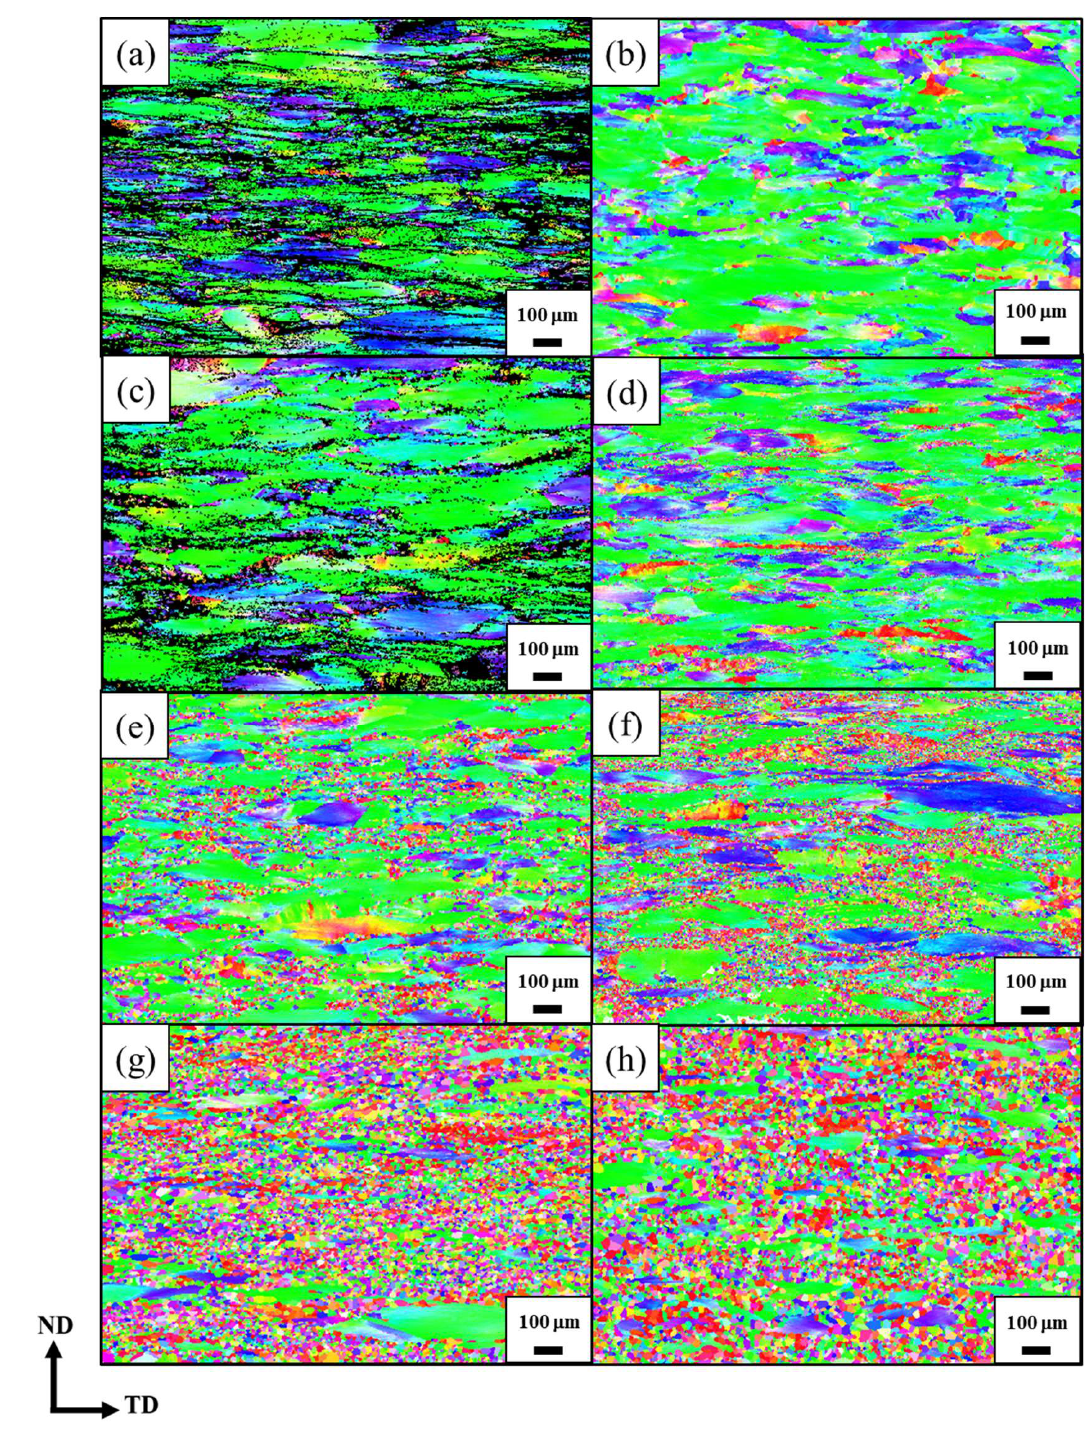
Figure 6. The EBSD images of CR70 and HR50CR70 Ti 65 (AlCrNbV) 28 Zr 7 MEAs with different annealing temperatures. ( a ) CR70-742 °C; ( b ) HR50CR70-742 °C; ( c ) CR70-812 °C; ( d ) HR50CR70-812 °C; ( e ) CR70-854 °C; ( f ) HR50CR70-854 °C; ( g ) CR70-881 °C; ( h ) HR50CR70-881 °C.